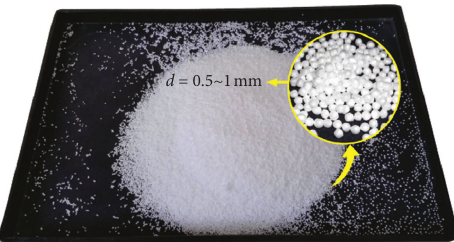
Figure 5: EPS particles used in the